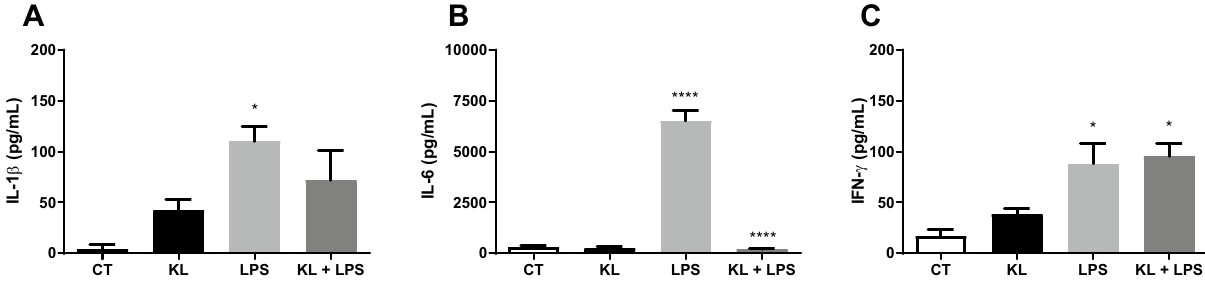
Figure 3. Effect of α-Klotho on IL-1β, IL-6, and IFN-γ levels in mouse cell glia challenged with LPS. The glial culture was pretreated with serum-free medium (control) or with 1 nM α-Klotho for 24 h, and then challenged with 1 µg/mL/mL LPS for 8 h. The supernatant was collected to measure the levels of IL-1β ( A ), IL-6 ( B ), and IFN-γ ( C ). One-way ANOVA analysis, followed by Tukey’s post-test, *p < 0.05, **p < 0.01, **** < 0.0001. Results are presented as mean ± SEM of 7 independent